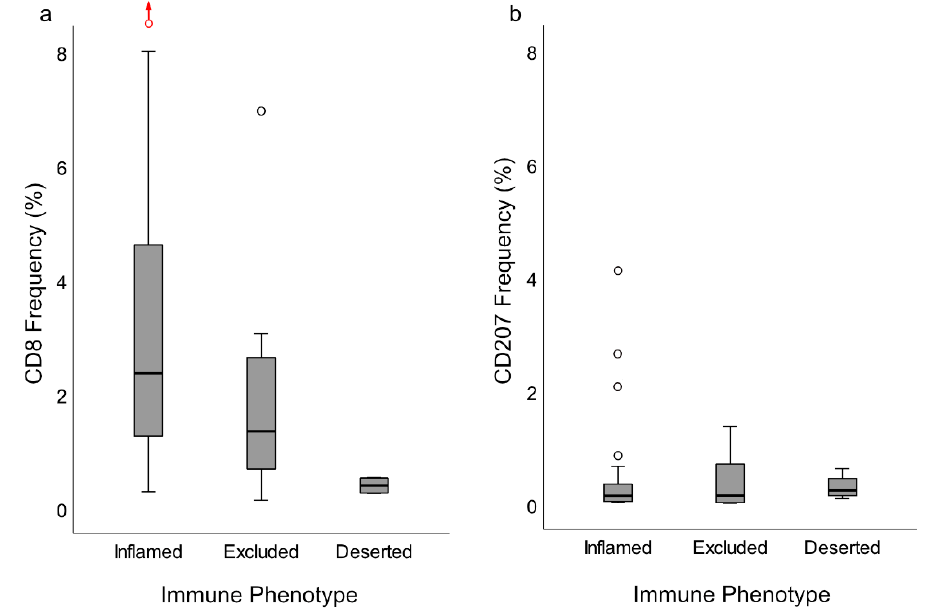
Figure 5. CD8 and CD207 frequency (%) of whole biopsies in relation to immune phenotypes presented as boxplots (median and IQR, with whiskers denoting 1.5 IQR and outliers as circles). ( a ) CD8 ratios di ff ered between immune phenotypes: “inflamed” and “excluded” ( p = 0.034, higher frequency for “inflamed”), “inflamed” and “deserted” ( p = 0.0020, higher frequency for “inflamed”), and “excluded” and “deserted” ( p = 0.022, higher frequency for “excluded”). ( b ) There was no di ff erence in CD207 ratios between immune phenotypes. In ( a ), an extreme outlier (frequency: 24%), deemed an accurate observation, is indicated with a red circle and an upwards pointing red arrow. Abbreviation: IQR = Interquartile